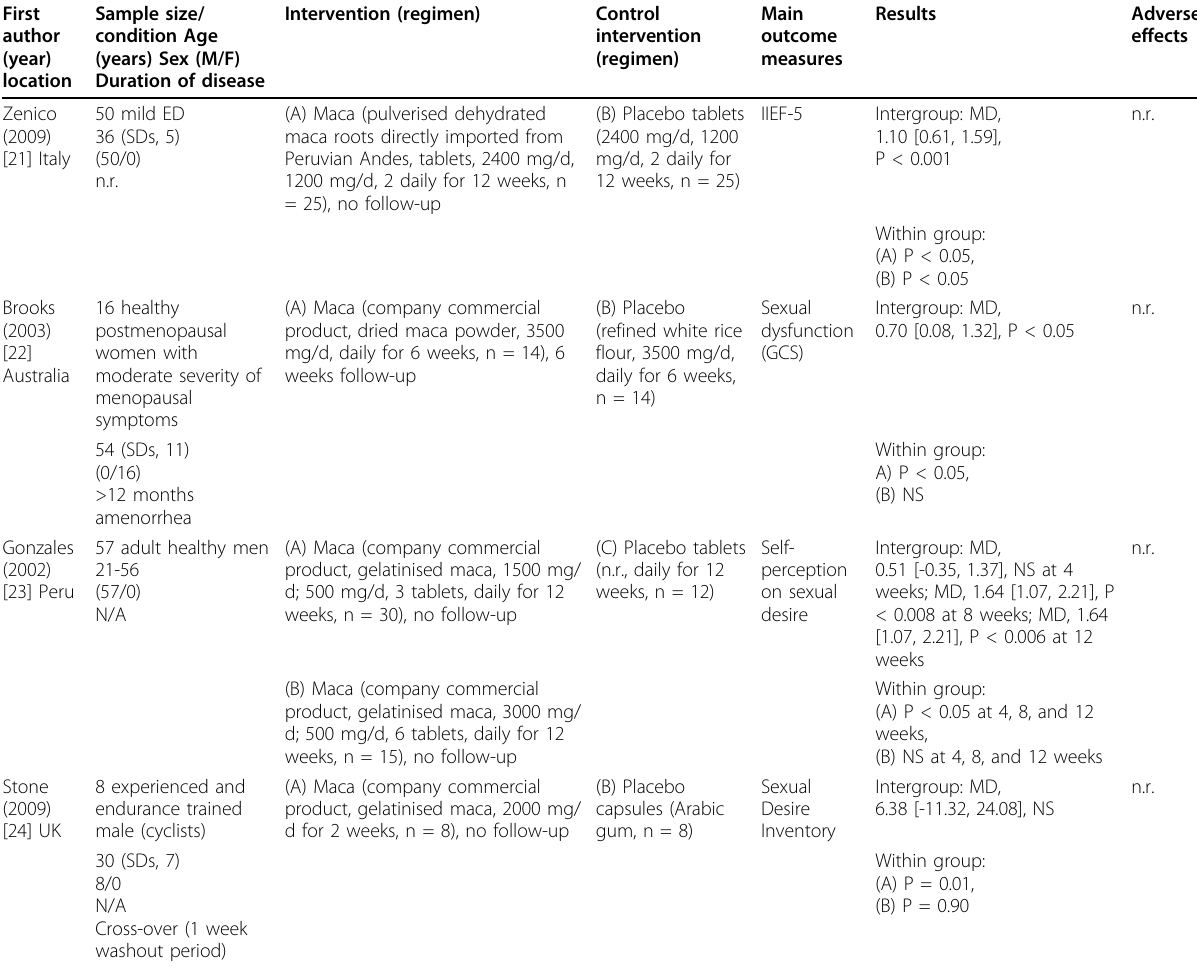
Table 1 Summary of randomised clinical trials with maca for sexual function First